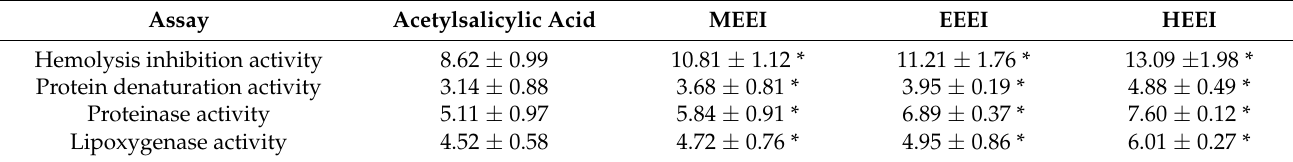
Table 6. IC 50 values (in µ g/mL) of the anti-inflammatory activity of the extracts of Enteromorpha intestinalis .